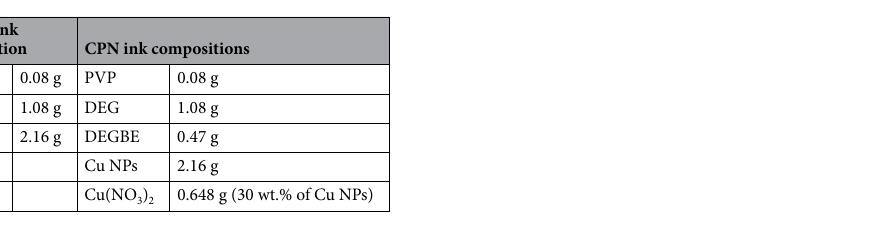
Table 1. Material composition of Cu NPs ink and CPN ink.